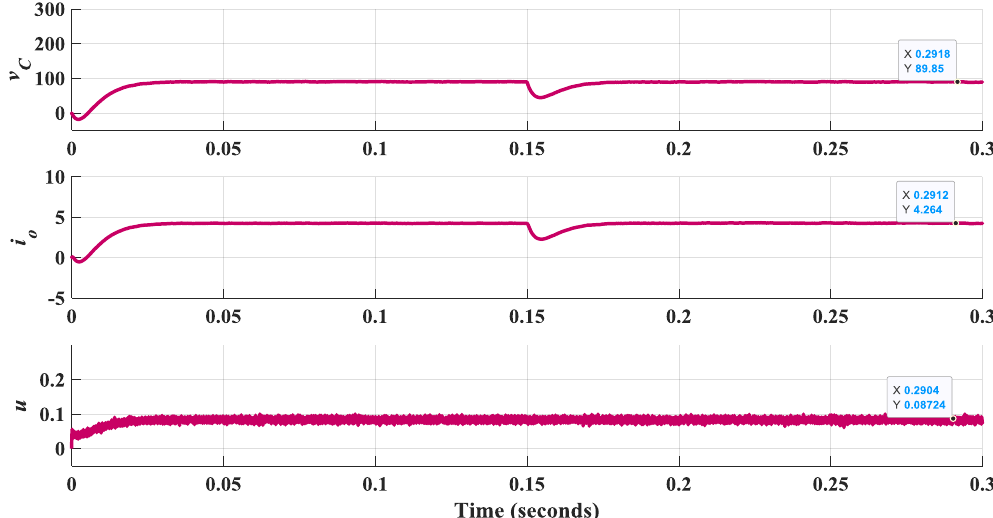
Figure 9. Simulation results for a load disturbance of 4 A under perturbed condition ( D = 0.4 and R o = 60).